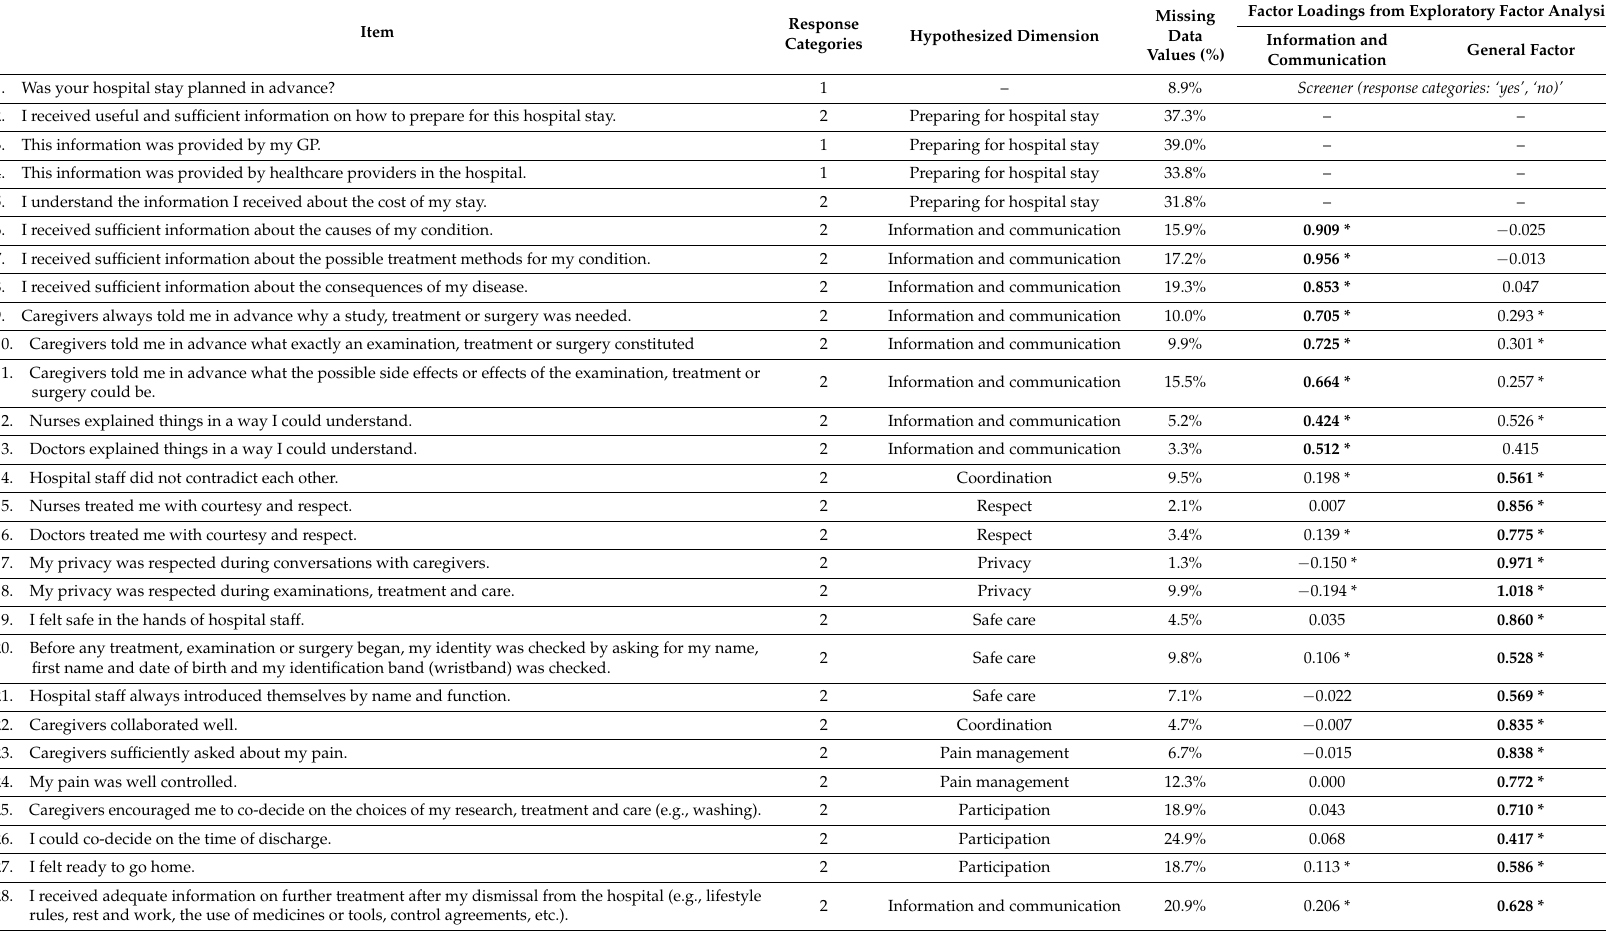
Table 1. Exploratory factor analysis for the preliminary version of the Flemish Patient